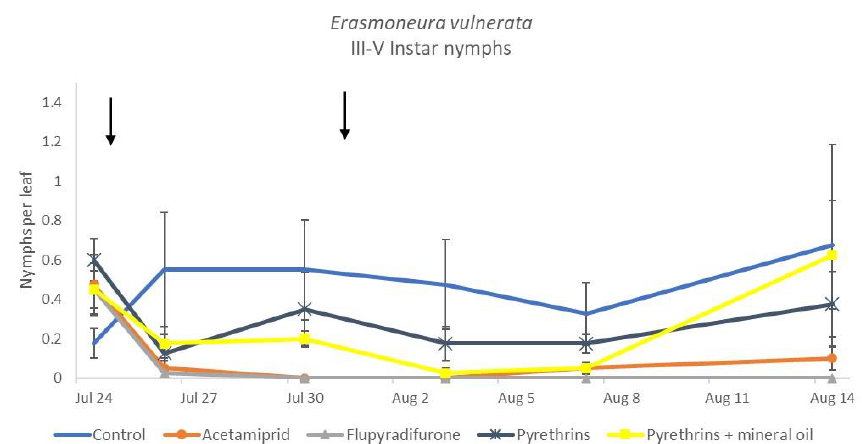
Figure 16. Dynamics of Erasmoneura vulnerata older (III-V instar) nymphs (mean ± std. err.) in the 2019 trial. Insecticides were applied one (first arrow) or two times (second arrow, see Materials and Methods section) .